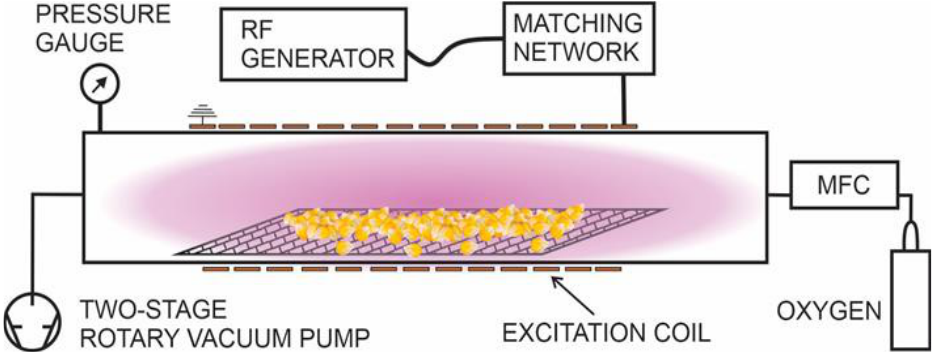
Figure 8. Schematic representation of industrial plasma reactor used to treat maize.